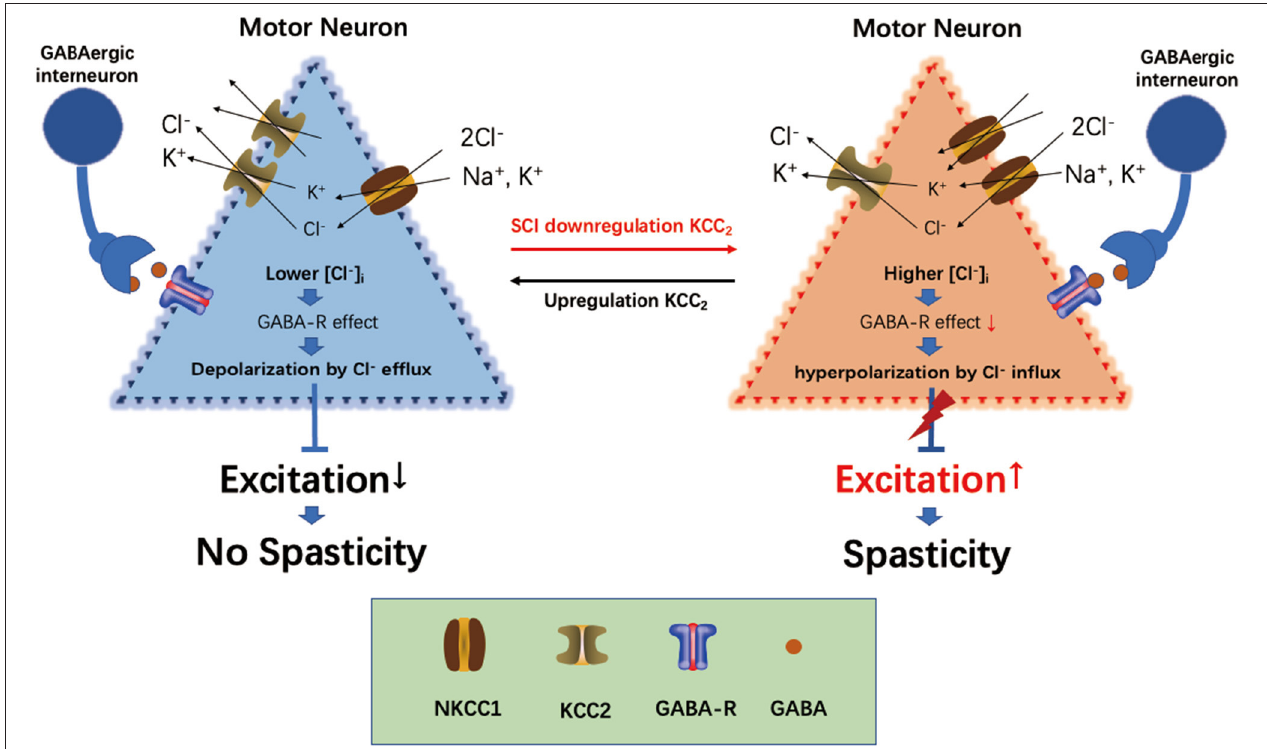
FIGURE 7 | Overview of current views on the role of KCC 2 , NKCC1, and GABA in spasticity induction following spinal cord injury (SCI).